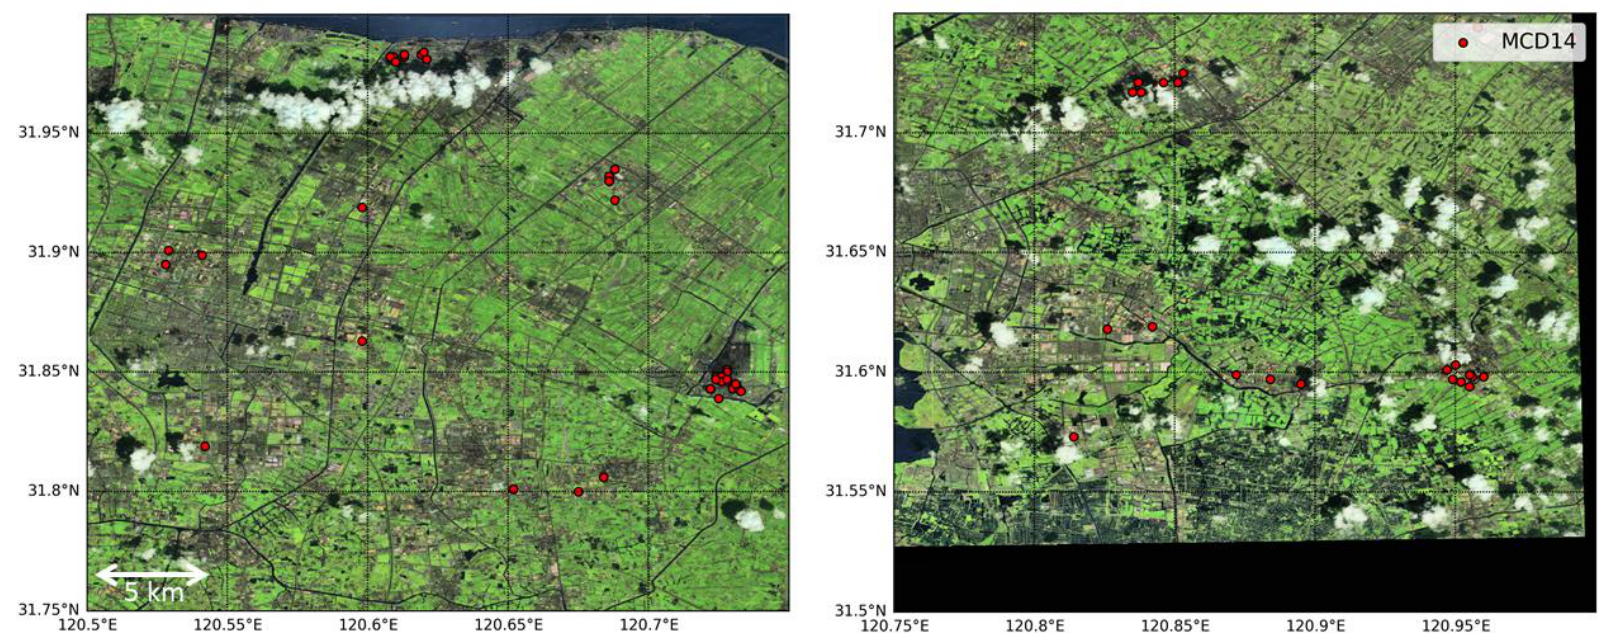
Figure 3. MODIS 1 km active fire (AF) detections produced using the algorithm described in [4] and displayed in red within two 0.25 deg × 0.25 deg areas (representing the areas of two GFED grid cells) in eastern China, overlaying Sentinel-2 true colour composites (centered at 31.875 ◦ N,120.625 ◦ E and 31.625 ◦ N,120.875 ◦ E respectively, retrieved on 22 August 2016). Every one of the MODIS AF detections can be seen to be located in an area where outdoor vegetation burning is unlikely to have occurred, for example in residential and industrial areas. None are on agricultural land, and it is therefore very likely that these AF detections are false alarms caused by manmade structures being warmer or more glint-inducing than their surroundings—as detailed in References [7,17]. Such effects mean AF detection algorithms are frequently subject to these types of false alarms in eastern China, and Reference [17] developed methods to mask these false alarms based on temporal persistence and landcover information. The MCD14 AF product does not apply such masking, so the false alarms remain, and their presence in areas not matched by MODIS burned area detections causes GFED4.1s to report significant burned area for these two grid cells (24 and 19 km 2 , respectively). These large burned areas come from the application of the ‘boosting’ methodology of [11] which is used within GFEDv4.1s to ‘boost’ burned area undetected by the MODIS MCD64A1 BA product. This SFB method takes MODIS AF detections located at sites where there is matching MCD64A1 detected burned area and, once a calibration between AF count and BA size is developed, uses the AF’s detected in areas where no MCD64A1 burned area detection occurs to estimate the ‘undetected’ BA from the presumed ‘small fires’ (see Figure 1f for locations of these cells and [11] for full details of the SFB methodology).